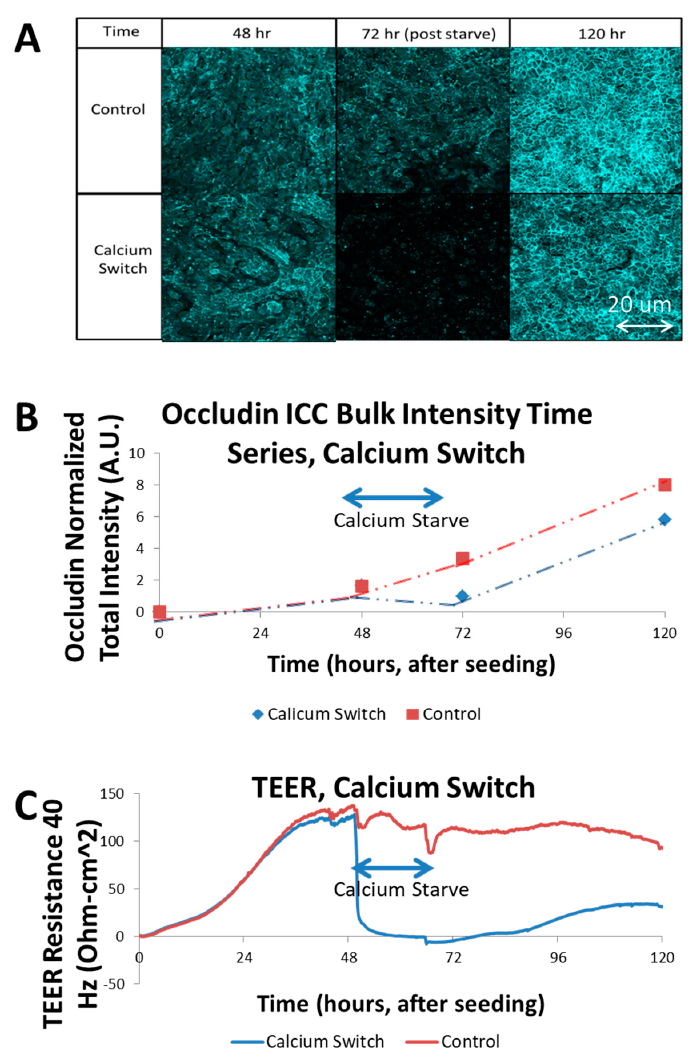
Figure 2. Calcium Switch Experiment trans-epithelial electrical resistance (TEER) vs. intra-class correlation (ICC): ( A ) Chart of immunofluorescence images, generated from maximum projections of Z-stacks of occludin-stained SIMS monolayers on PC membranes extracted from Transwells.